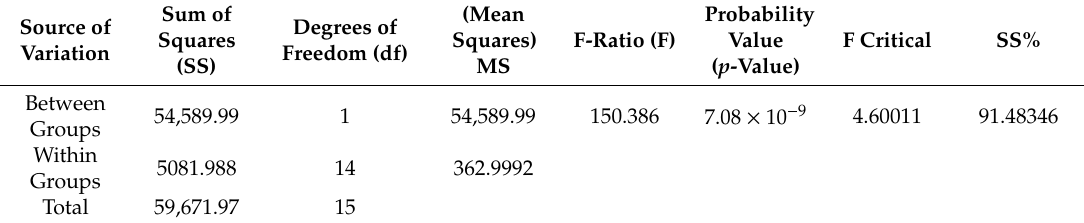
Table A5. ANOVA: Single Factor (Rm).